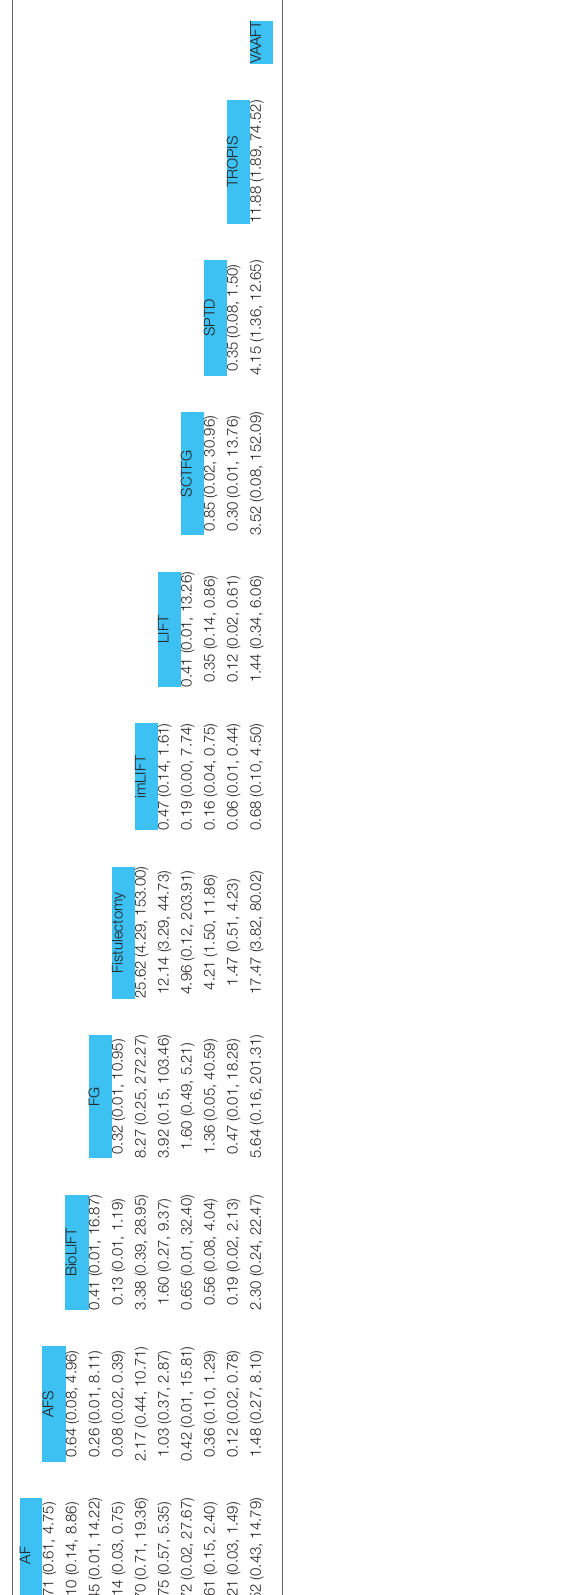
TABLE 5 | Ranking of probabilities for each intervention (SUCRA,